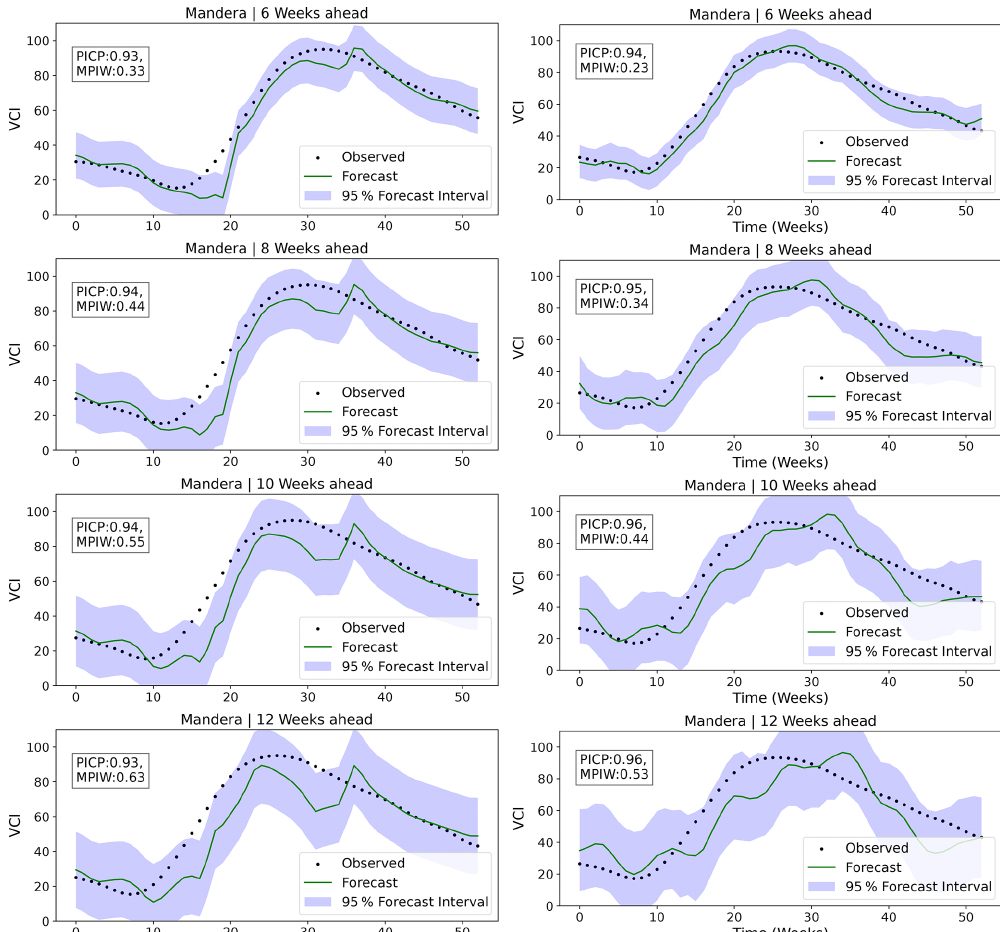
Figure 7. Time series plot showing uncertainty for 6-, 8-, 10-, and 12-week lead time for Mandera County. Plots on the left side are from the AR model, and plots to the right are BARDL. The PICP and MPIW for the other counties can found in Appendix A. The forecast line (green line) represents the mean values of the BARDL